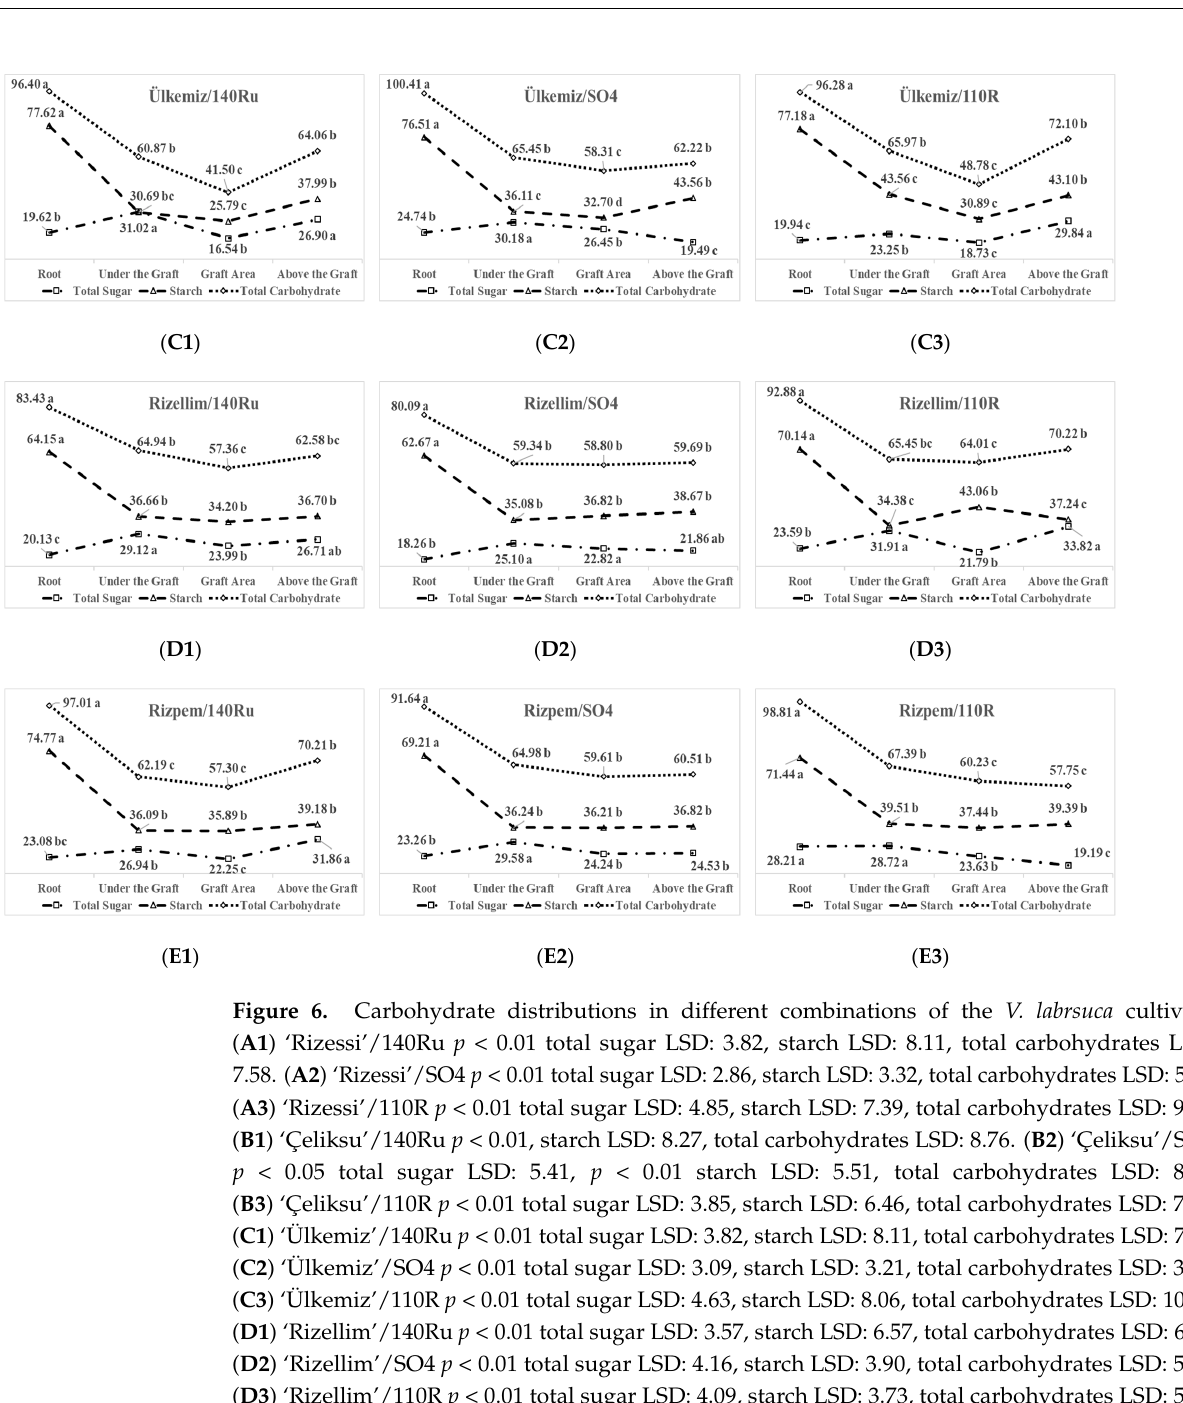
differences between results shown with different letters on the same lines are statistically